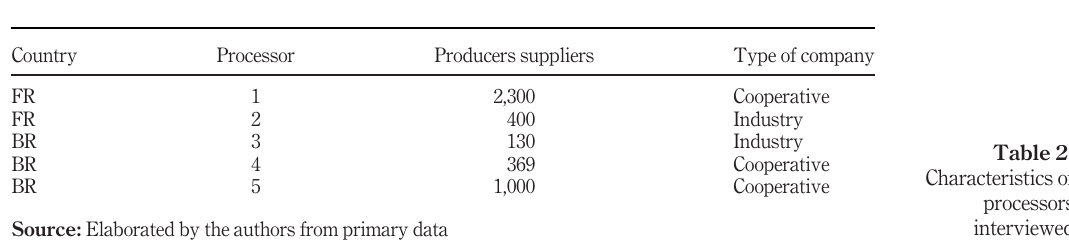
Table 2. Characteristics